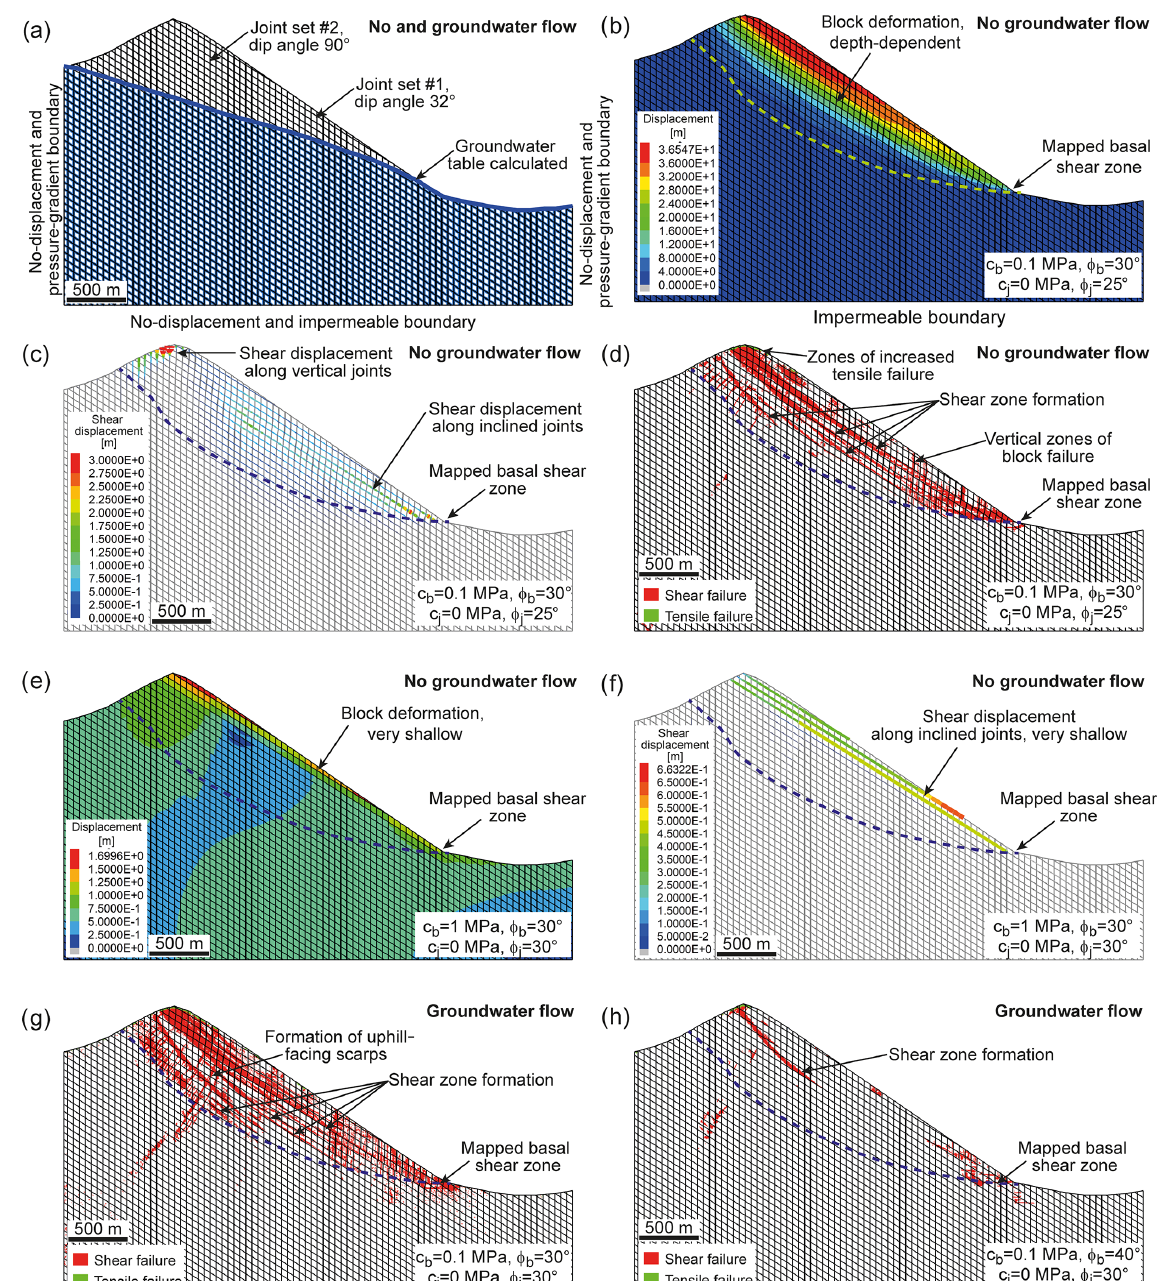
Figure 8. Results of modelling scenario I: (a) model set-up presenting the joint network and the calculated groundwater situation, (b) depth- dependent distribution of block displacements by implementing a block cohesion of c b = 0 . 1MPa and internal friction angle of φ b = 30 ◦ , (c) spatial distribution of shear displacements along joints ( c b = 0 . 1MPa, φ b = 30 ◦ ), (d) formation of multiple shear and antithetic zones due to block shear failure in a line-shaped arrangement ( c b = 0 . 1MPa, φ b = 30 ◦ ), (e) model run showing very shallow block displacements when block cohesion was increased from c b = 0 . 1 to c b = 1MPa ( φ b = 30 ◦ ), (f) shallow-occurring shear displacements along joints for c b = 1MPa and φ b = 30 ◦ , (g) model run considering groundwater flow showing the formation of multiple shear and antithetic zones (i.e. uphill-facing scarps) due to block shear failure ( c b = 0 . 1MPa, φ b = 30 ◦ ), and (h) model run with groundwater flow showing the formation of a single shear zone being initiated mainly in the summit area and at the foot of the slope when the friction angle is increased to φ b = 40 ◦ ( c b = 0 . 1MPa). All model runs presented reached